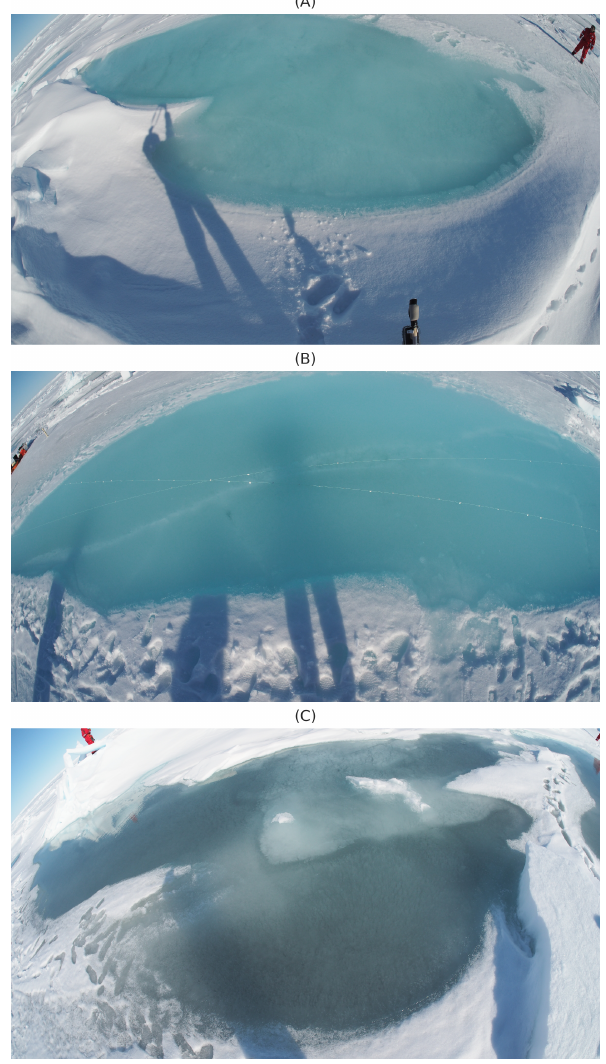
Figure 4. Photos of the small (a) and large (b) bright ponds and the dark pond (c) . Photos: Peter Gege.